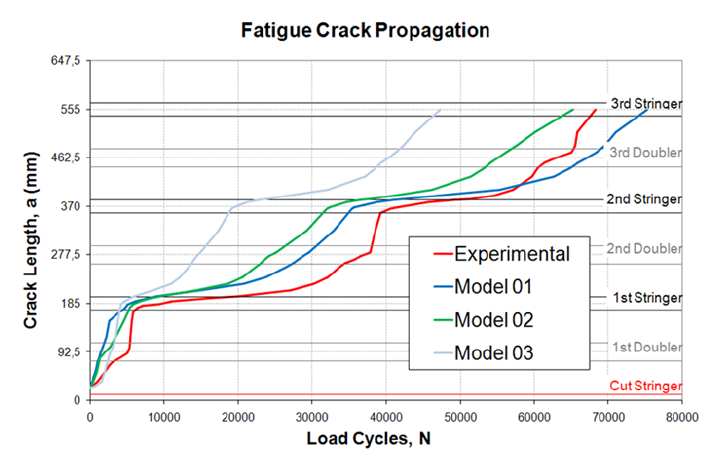
Figure 15: Comparison between experimental and numerical FCP curves (Models 01, 02 and